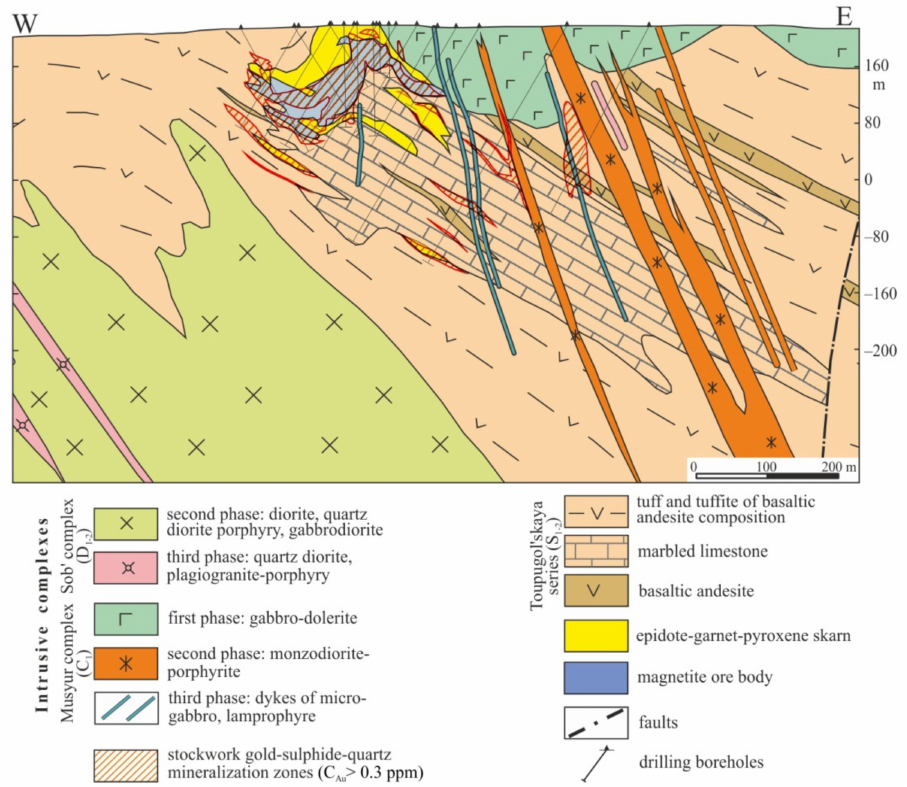
Figure 3. Geological cross-section of the Novogodnee-Monto gold-iron deposit along line I–II on Figure 2, compiled using data in Reference [43] and JSC “Yamalgold”, simplified after [45].